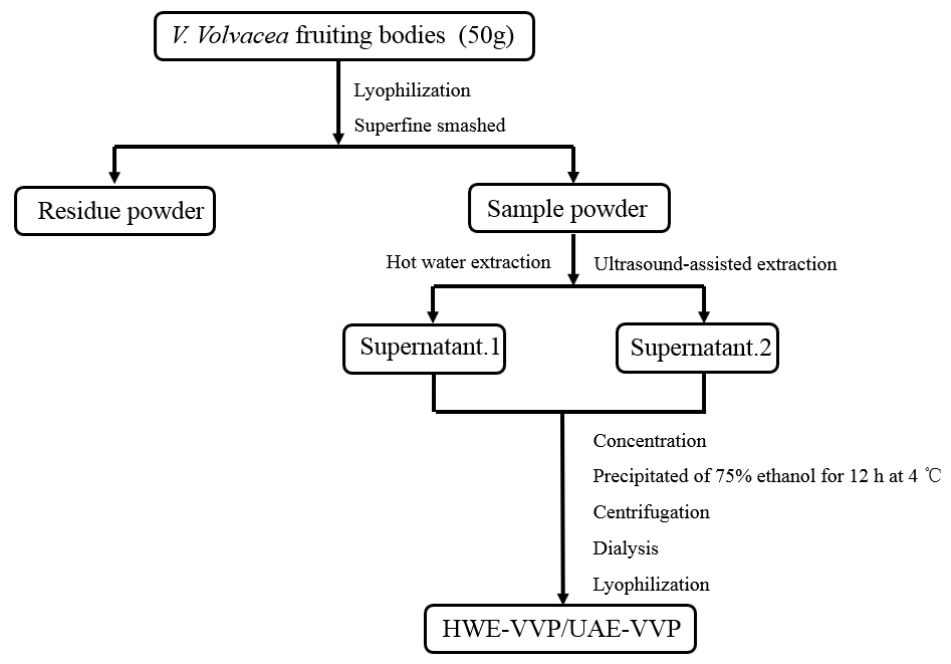
Figure 4. Stepwise scheme of V. volvacea polysaccharide extraction using ultrasound-assisted extraction (UAE) and hot water extraction (HWE).